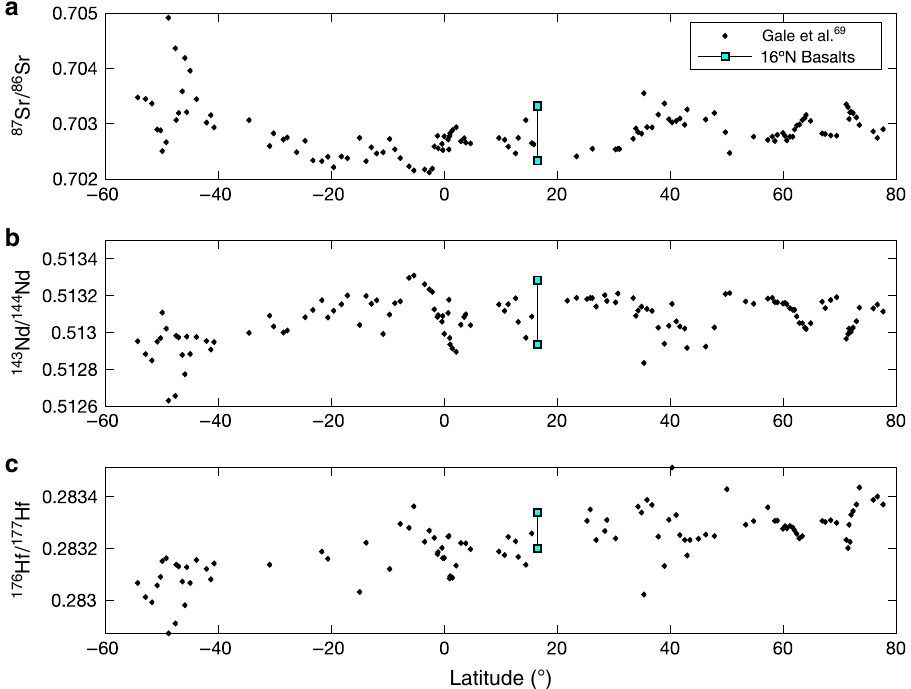
Fig. 1 Mid-ocean ridge basalt isotopic variability along the Mid-Atlantic Ridge. MORB segment averages of 87 Sr/ 86 Sr ( a ), 143 Nd/ 144 Nd ( b ) and 176 Hf/ 177 Hf ( c ) from Gale et al. 69 exemplify the time-integrated source heterogeneity observed in Mid-Atlantic Ridge basalts. 16°N region, labeled, shows the heterogeneous nature of source material on scales of tens of kilometers, typical for Atlantic MORB. 16°N samples are given as a range with data from Henrick 70